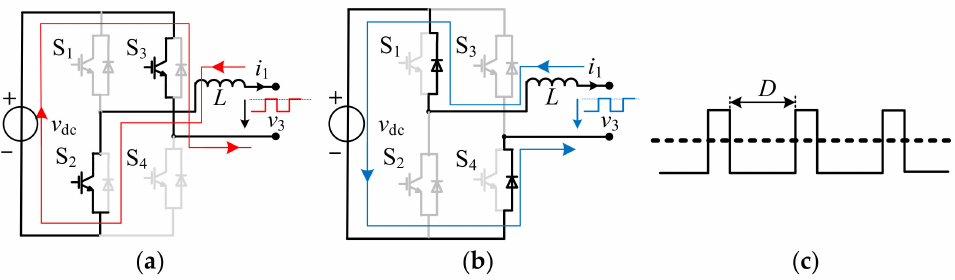
Figure 4. CCC-NVC state analysis: ( a ) current path when S 2 and S 3 are both on; ( b ) current path when S 2 and S 3 are both off; and ( c ) output voltage.